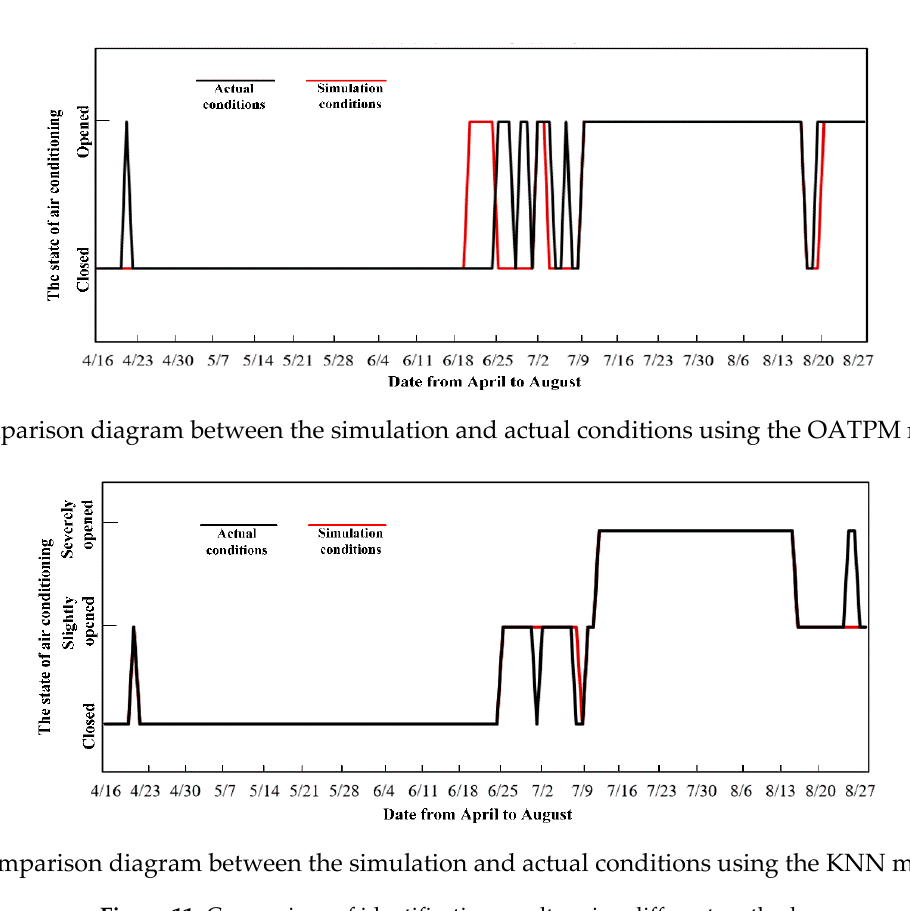
Figure 14. Comparison of identification results using different methods. Figure 11. Comparison of identification results using different Table 4. Comparison of the OATPM and KNN methods.